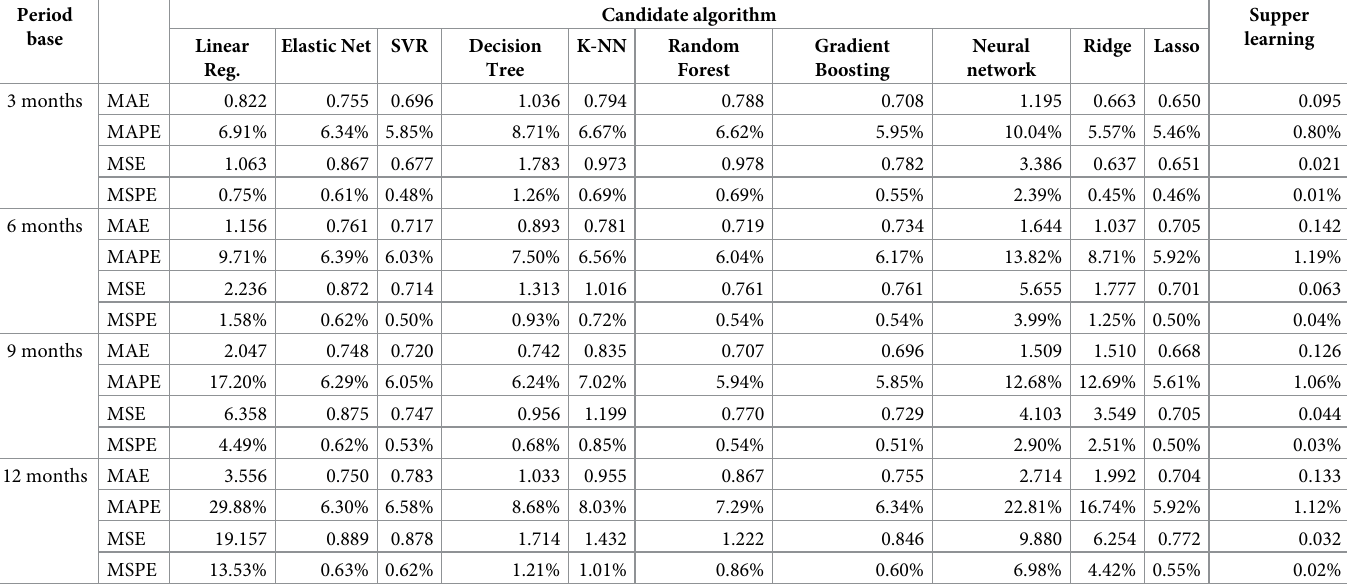
Table 3. Prediction for 3, 6, 9, and 12 months